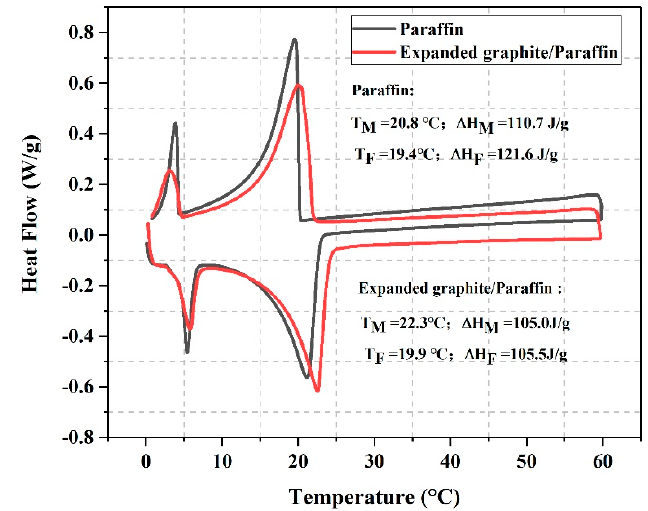
Figure 5. DSC (Differential Scanning Calorimeter) curves of paraffin and expanded graphite/paraffin.